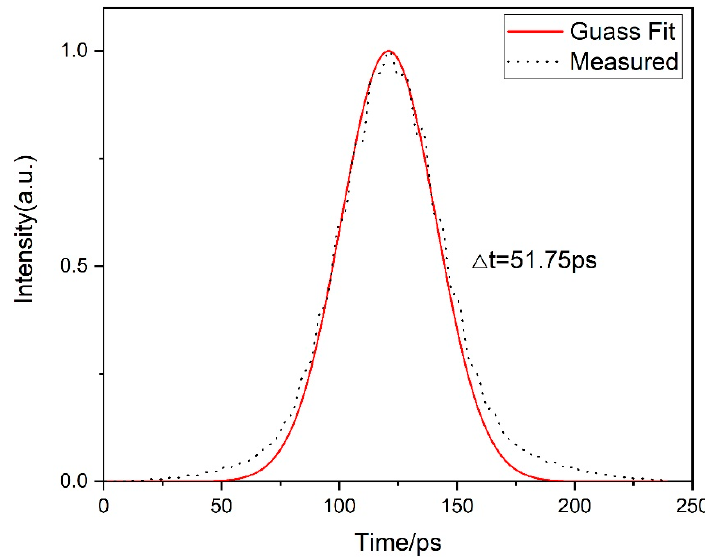
Figure 2. Intensity autocorrelation trace of the Nd:YVO 4 oscillator.